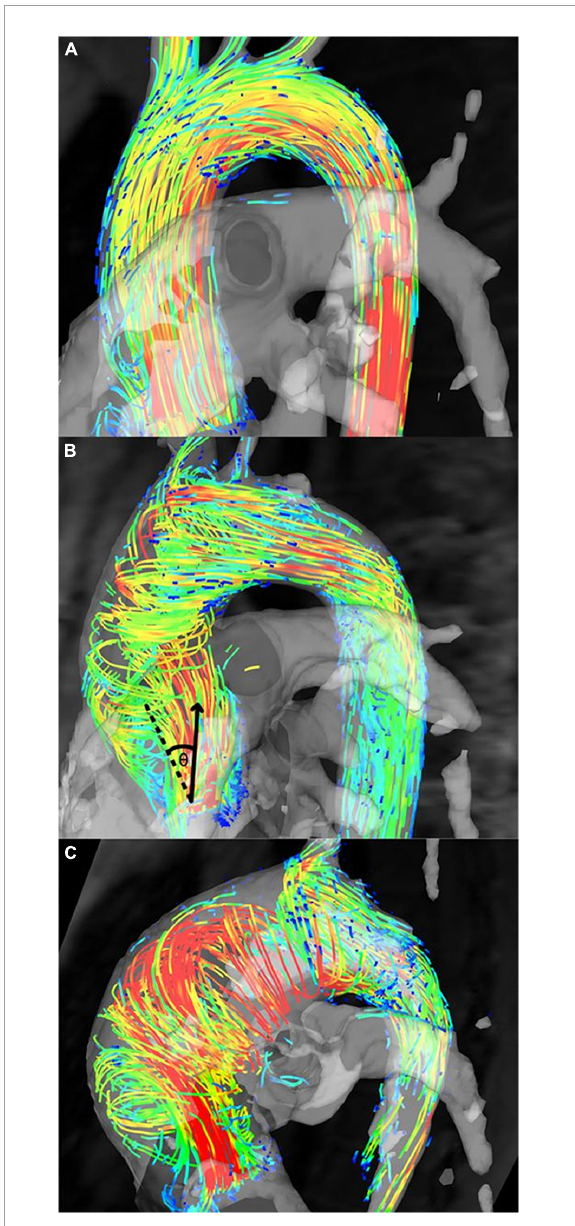
FIGURE7 Flow patterns in bicuspid aortic valve (BAV) patients. (A) Normal flow pattern in subjects associated with similar aortic diameters to healthy volunteers but mildly increased rotational flow, (B) right-handed helical flow in subjects associated with larger aortic diameters and rotational flow values than healthy volunteers, and (C) left-handed helical flow in subjects associated with even larger aortic diameters than subjects in panel (B) and healthy volunteers (10). Permission to reproduce obtained from Wolters Kluwer